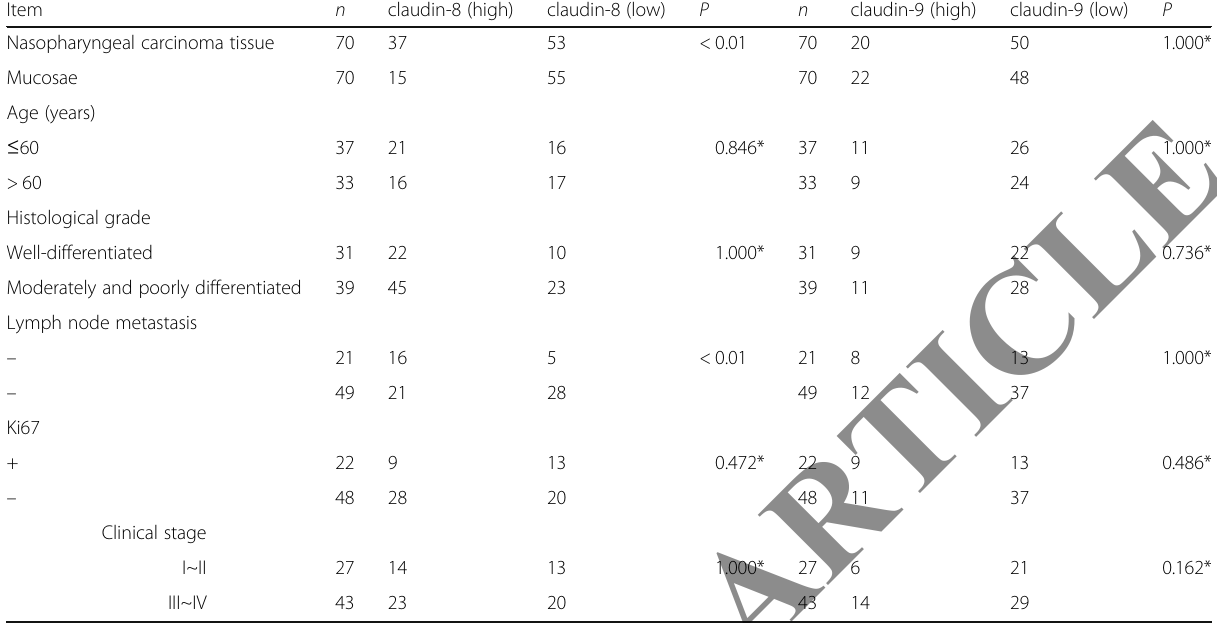
Table 2 Expression of claudin − 8 and claudin − 9 and the clinicopathological characteristics in nasopharyngeal carcinoma patients Item n